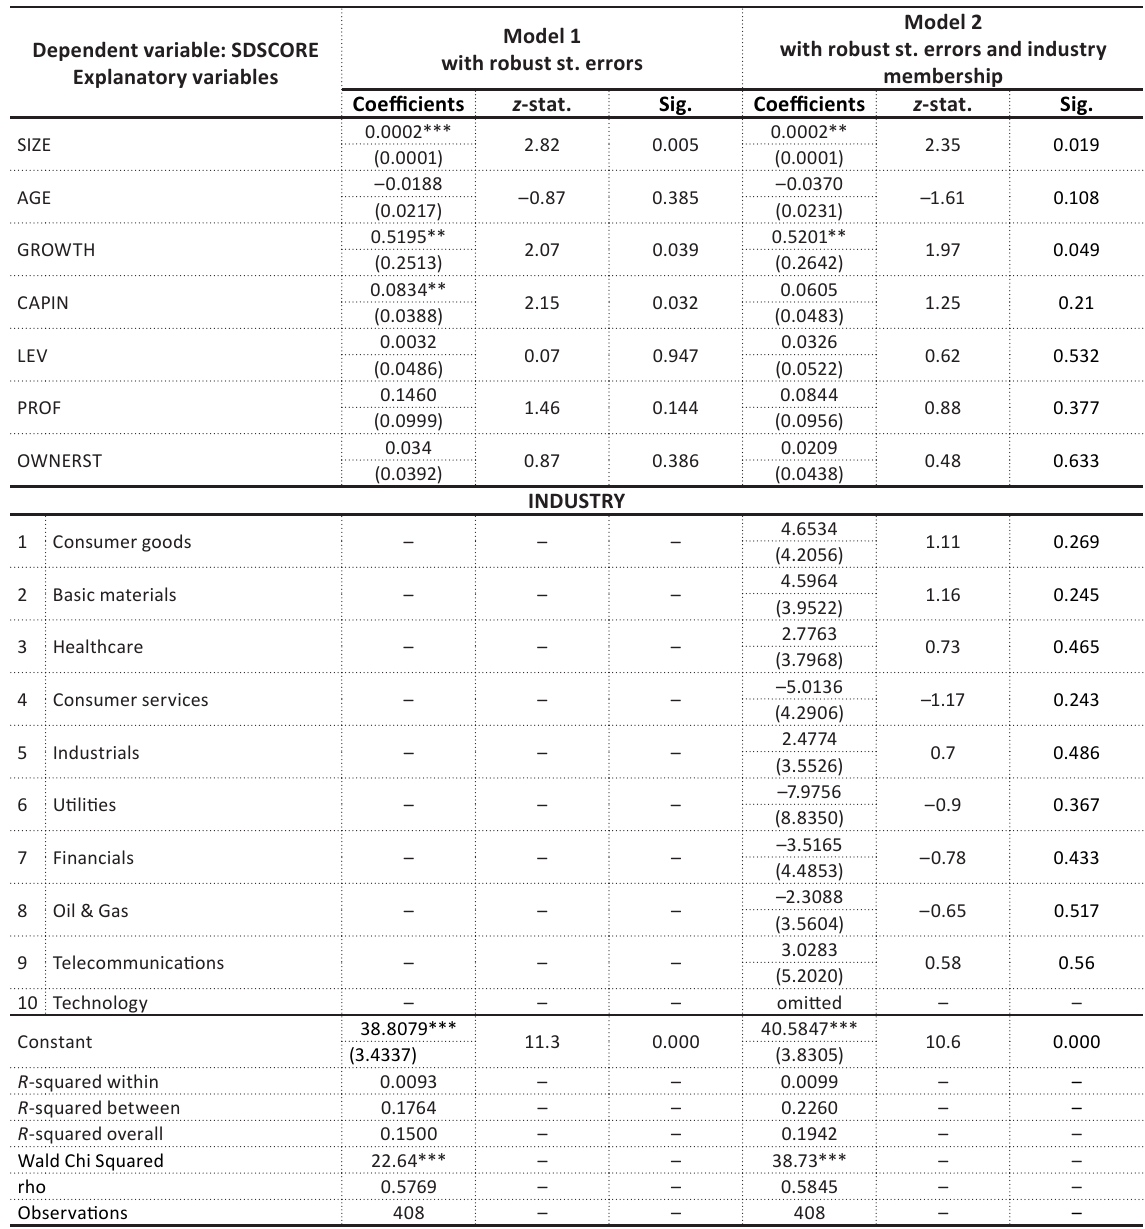
Table 4. Results of multiple regression